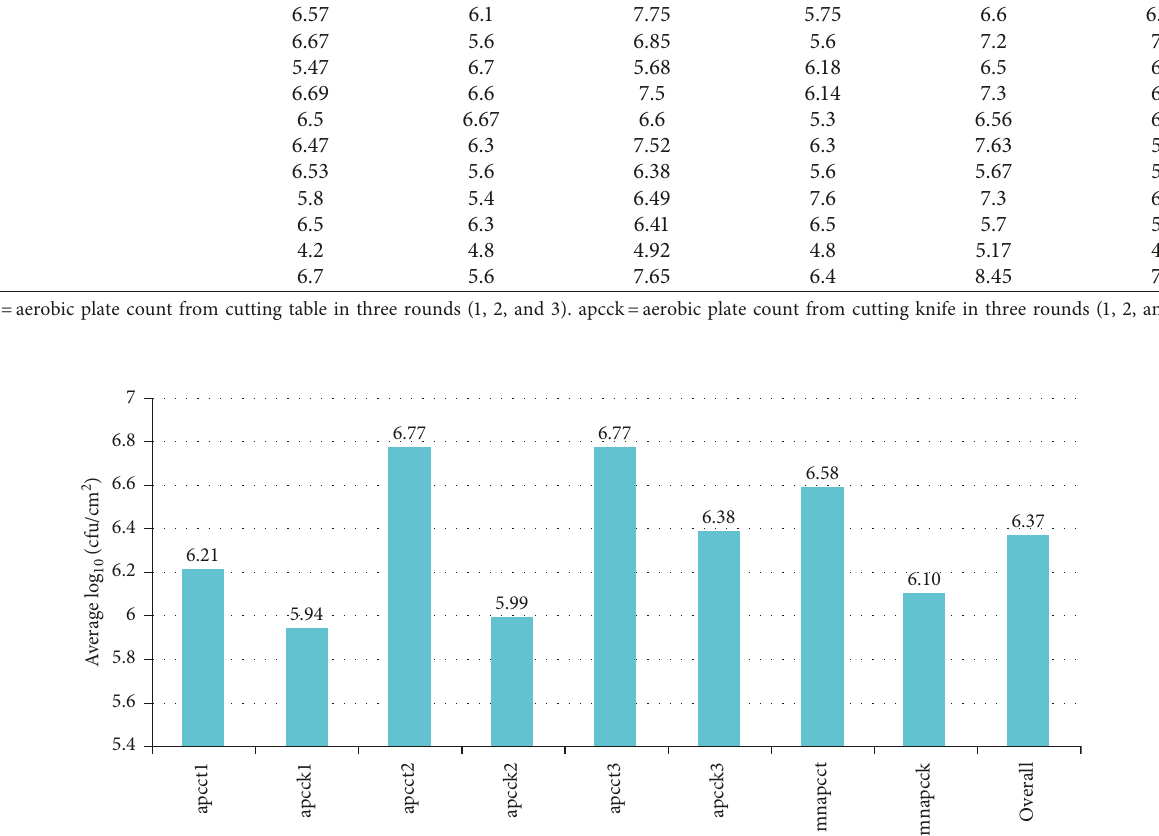
Table 4: APC from cutting knife and cutting table of butcher shops in log